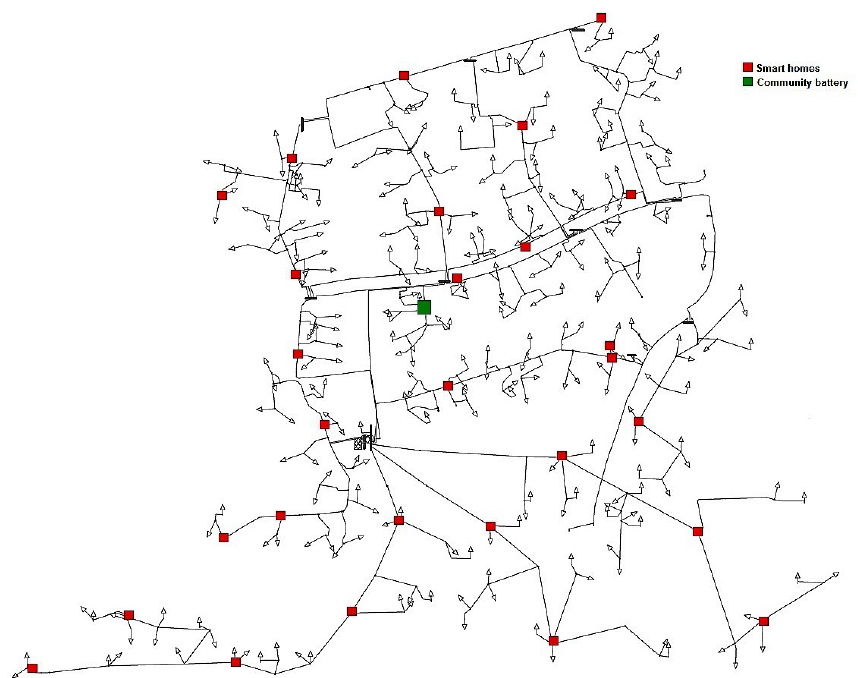
Figure 5. Topology of a real network in Austria with various smart buildings and a community battery.